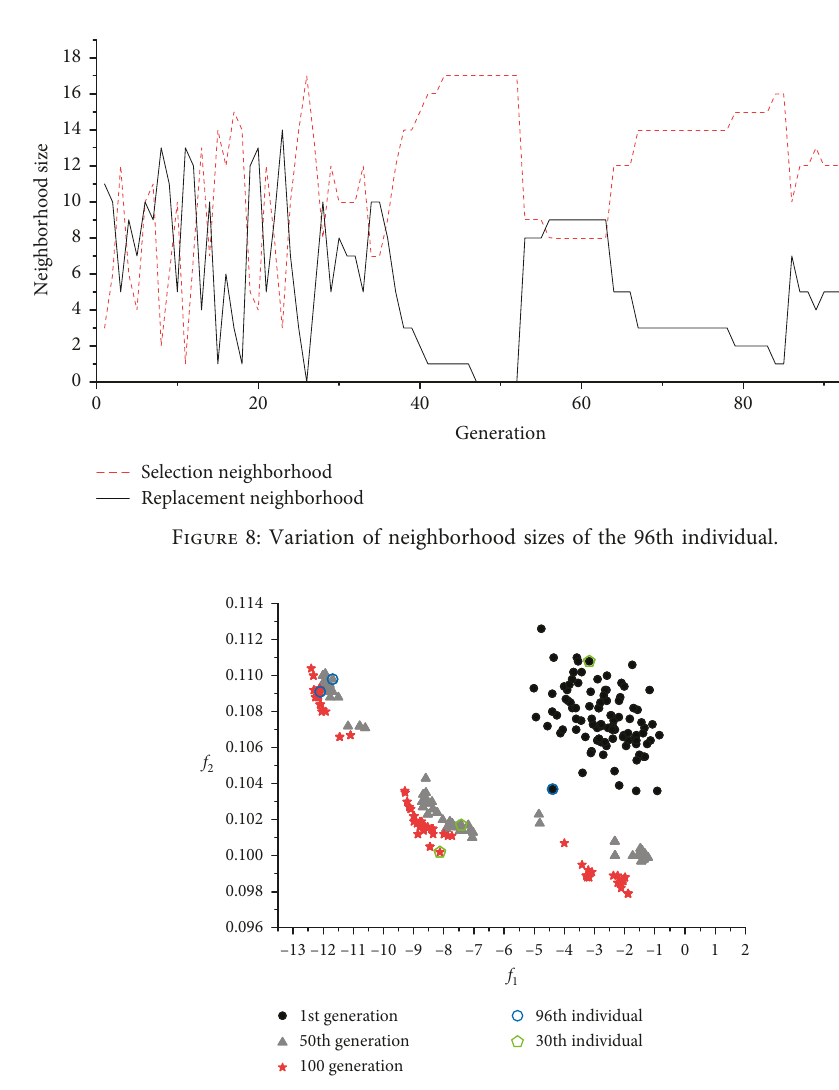
Figure 7: Variation of neighborhood sizes of the 30th individual.